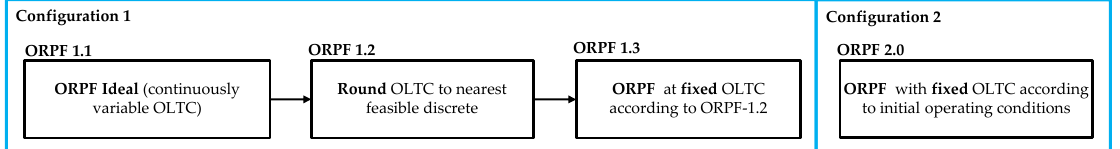
Figure 16. Local vs Coordinated Control real power losses: ( a ) profile; ( b ) aggregated.